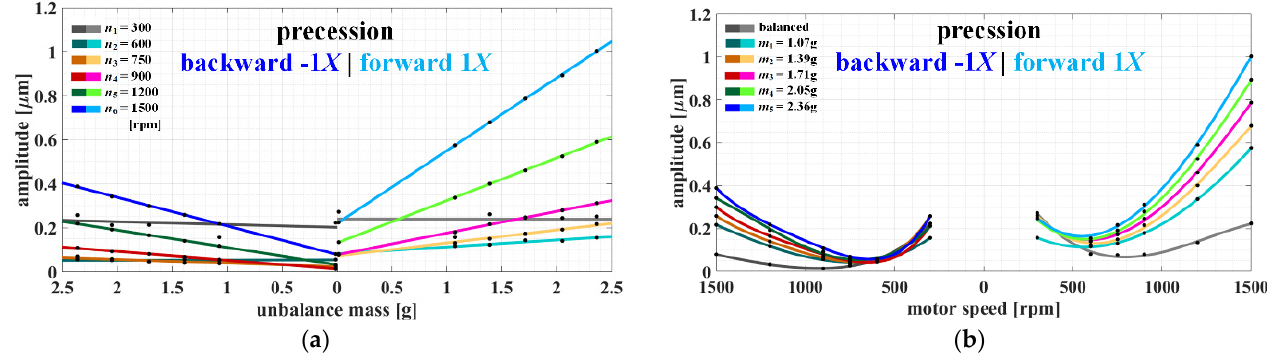
Figure 12. Backward (–1 X ) and forward (+1 X ) precession symptoms of rotor axis displacement as a function of changes of unbalance mass, m n ( a ), and rotational speed, n ( b ).